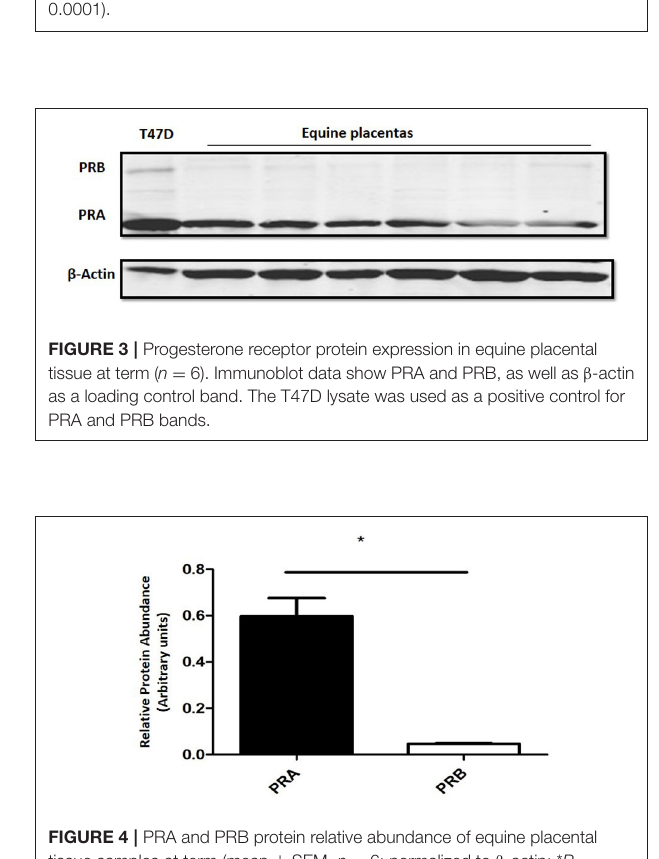
FIGURE 2 | Relative mRNA abundance encoding PRA and PRB determined by qPCR in equine placental tissue samples (mean ± SEM, n = 6; * P < 0.0001).